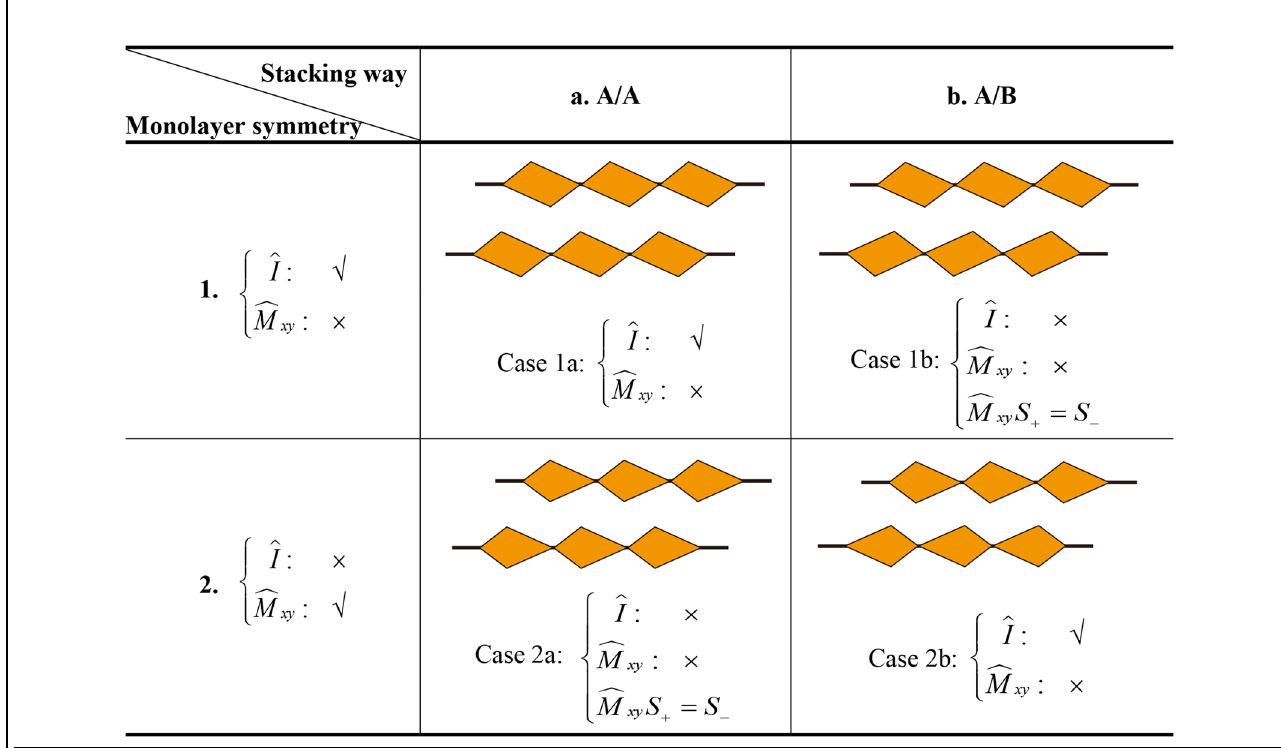
Table 1. Symmetries of interlayer-sliding bilayer materials.